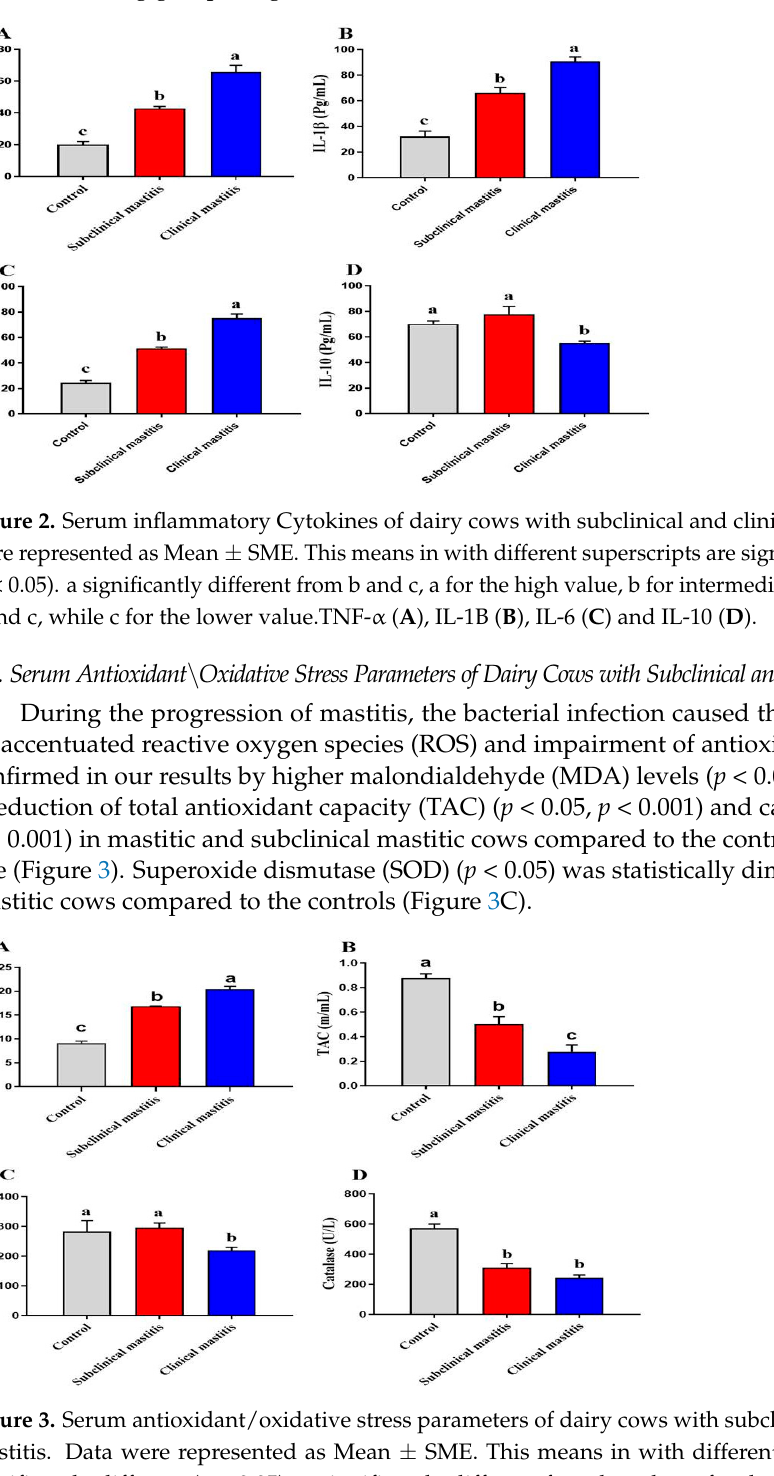
Figure 1. Serum Acute phase protein of dairy cows with subclinical and clinical mastitis. Data were represented as Mean ± SME. This means in with different superscripts are significantly different ( p